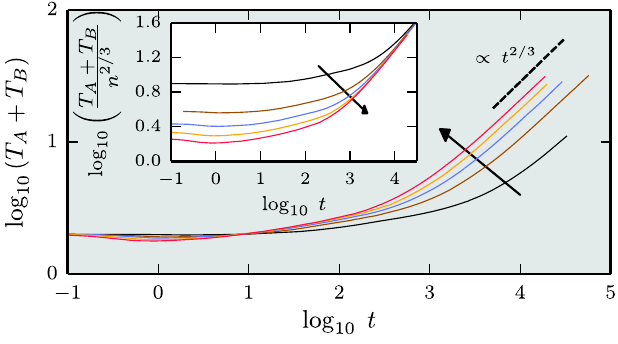
FIG. 2. Time dependence of the total kinetic energy (no damping). The development obtained from the simulations for T 1 and different ϕ (0.1, 0.3, 0.5, 0.7, 0.9, increasing along 0 ¼ the arrow) is shown. The inset demonstrates the ∝ n 2 = 3 density scaling of the asymptotic temperature growth. The temperature and time units are the same as in Fig. 1.